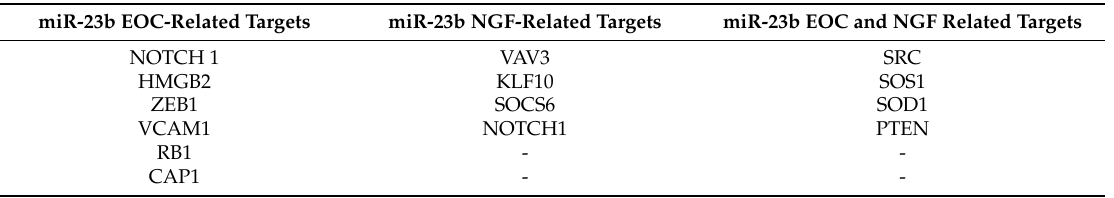
Table 1. miR-23b validated targets from miRWalk 2.0.